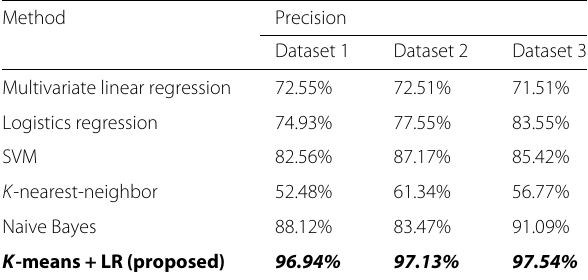
Table 7 Performance comparison